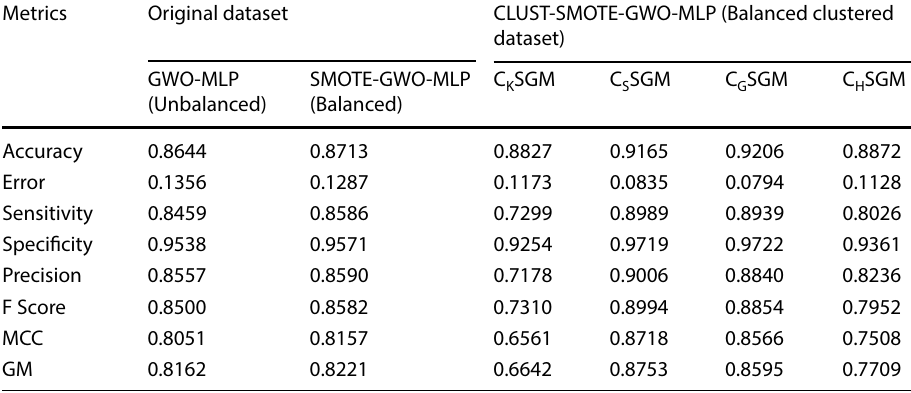
Table 10 Classification performance of GWO-MLP, SMOTE-GWO-MLP and CLUST-SMOTE-GWO-MLP